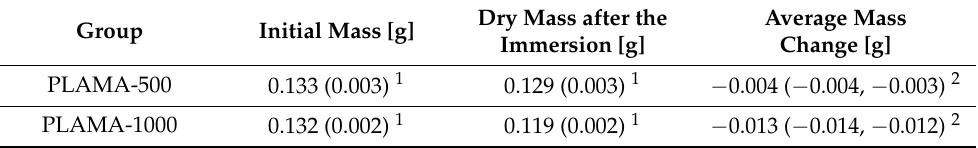
Table 6. Mass changes in specimens after the SBF immersion test (84 days).